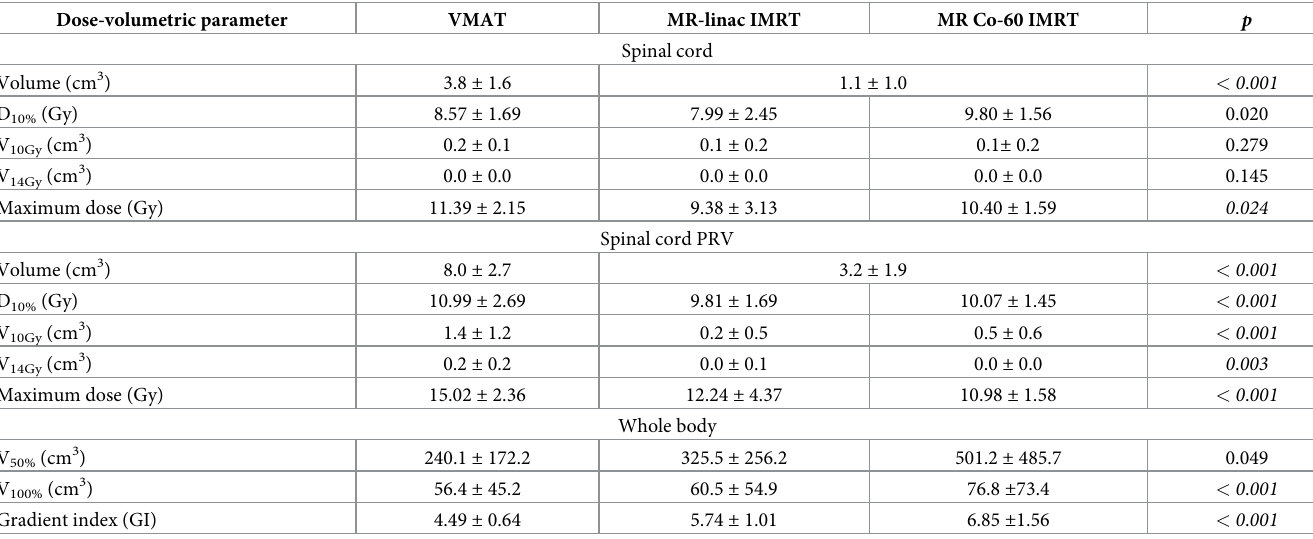
Table 3. Average dose-volumetric parameters of the spinal cord, spinal cord PRV, and whole body of VMAT, MR-linac IMRT, and MR-Co-60 IMRT plans. Dose-volumetric